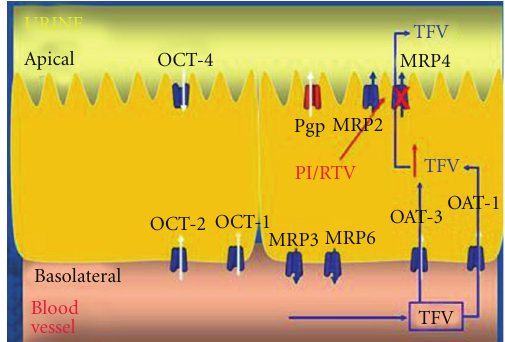
Figure 1: Tenofovir is predominantly eliminated via a combination of glomerular filtration and active tubular secretion. It enters into the kidney cell from the basolateral side via organic anion transporters, OAT-1 and OAT-3 [44], and leaves either via P glycoprotein, MRP2, and/or MRP4 [45]. Inhibition of MRP4 by PI/RTV leads to increased intracellular tenofovir levels which may increase its nephrotoxic e ff ects. OAT: organic anion transporter; MRP: multidrug resistant protein; PI/RTV: ritonavir-boosted pro- tease inhibitor; TFV: